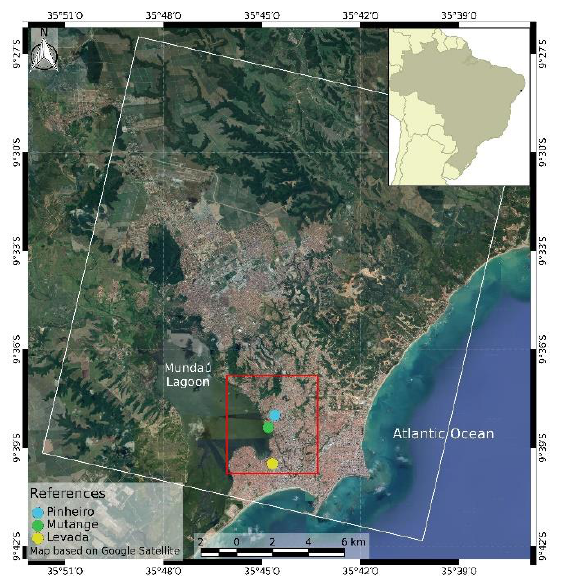
Figure 1. City of Maceió and area covered by the Sentinel 1 sub- swath (white polygon). Deformation results inside the red box where used by the inversion algorithm.